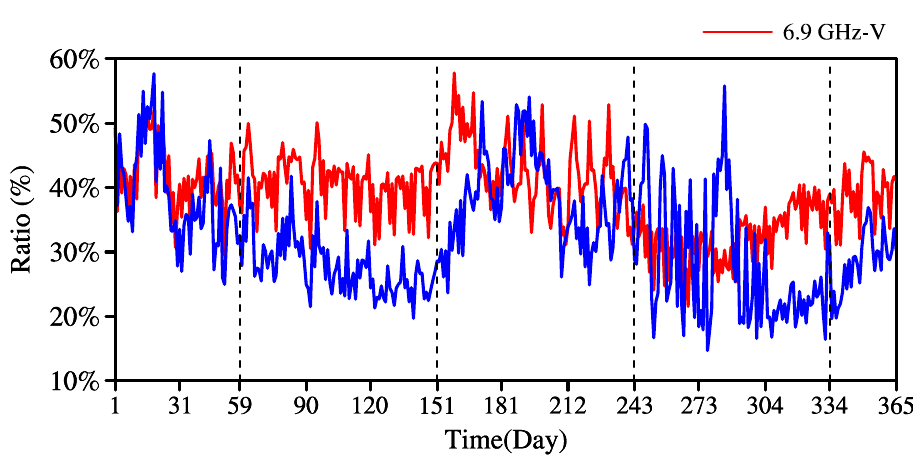
Figure 3. Daily variation curves of the proportion of pixels affected by RFI in the study domain for the 6.9-GHz-H (blue) and 6.9-GHz-V (red) channel in 2016.